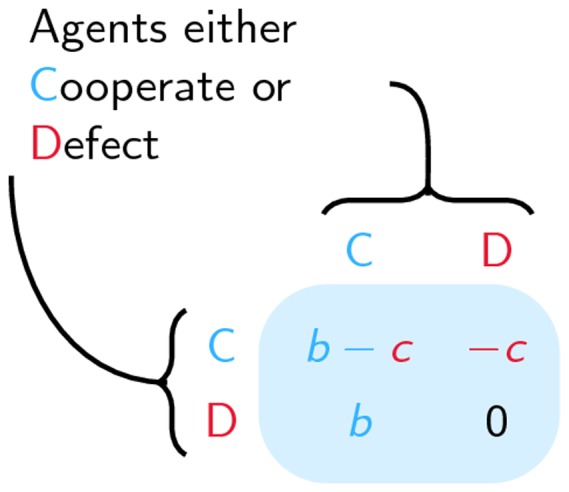
Prisoner's Dilemma.Both players have the option to either Cooperate or Defect. Whenever an agent cooperates, it costs him c while his partners receives a benefit b>c, leading to the indicated payoffs.